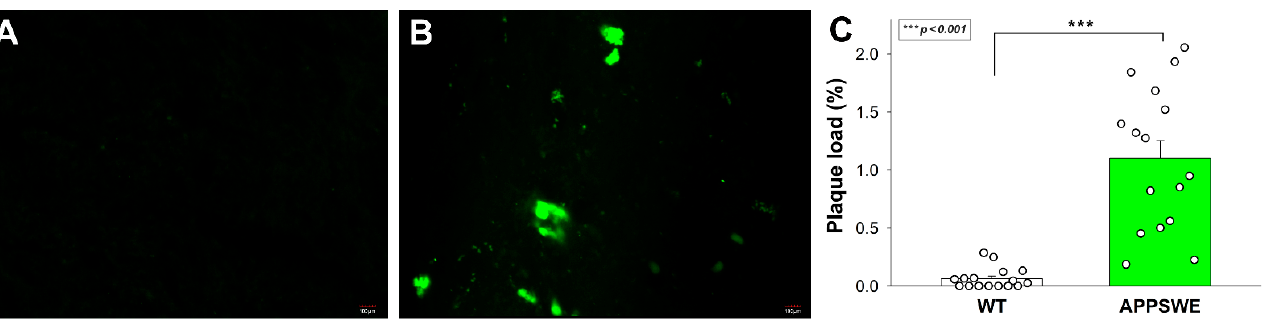
Figure 2. APPSWE-Tau mice exhibits significantly increased amyloid plaque load. ( A , B ) Representative brain slices WT ( A ) and APPSWE-Tau mice ( B ) stained with A β 1-42 antibody. Scale bar = 100 µ m. ( C ) The amyloid plaque load was quantified on A β 1-42 antibody–stained frontal brain slices from 12-month-old APPSWE-Tau and WT mice. Each group contained 8 animals; the plaque load was measured in two slices of each animal. Data are expressed as mean + SEM. *** p <